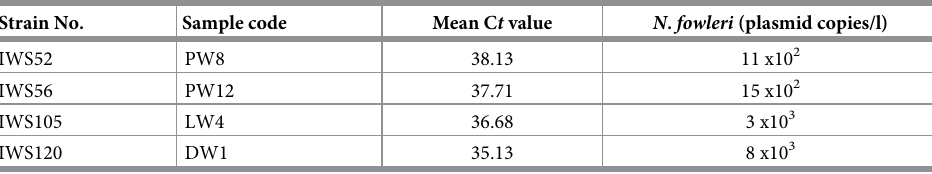
Table 3. Result of the qPCR assay for Naegleria fowleri in various waters. Strain